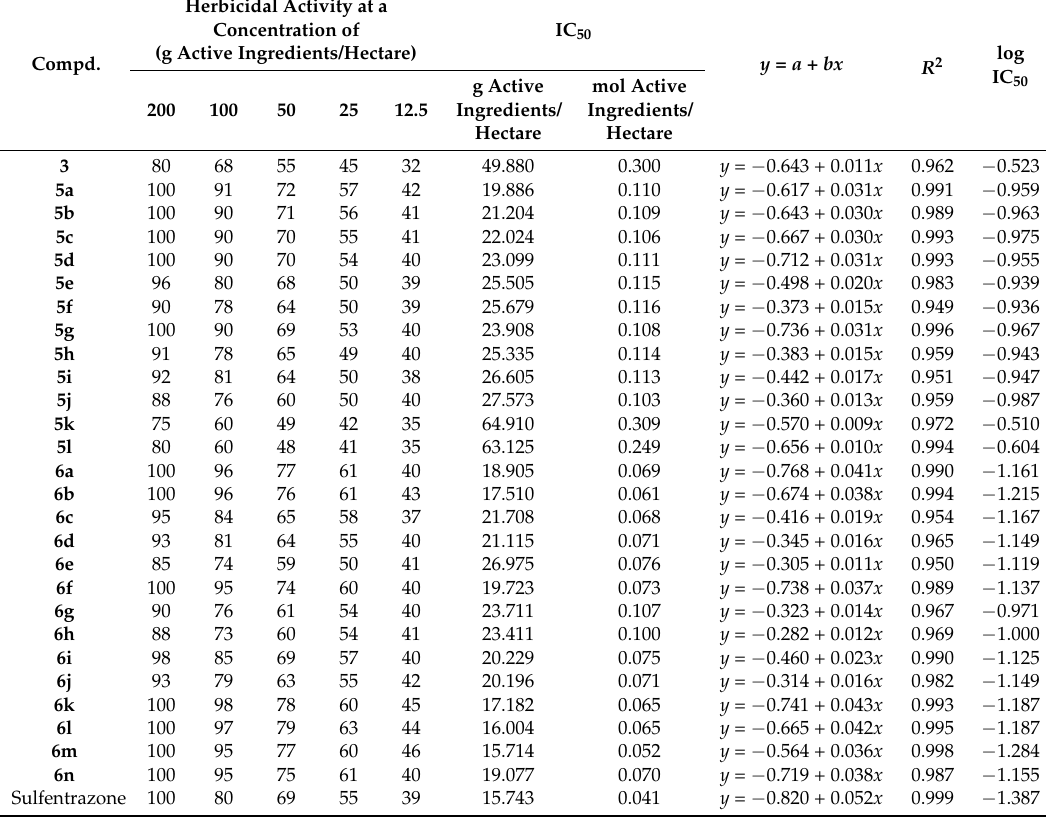
Table 1. Herbicidal activity of compounds against E. crus-galli in a seed germination method.